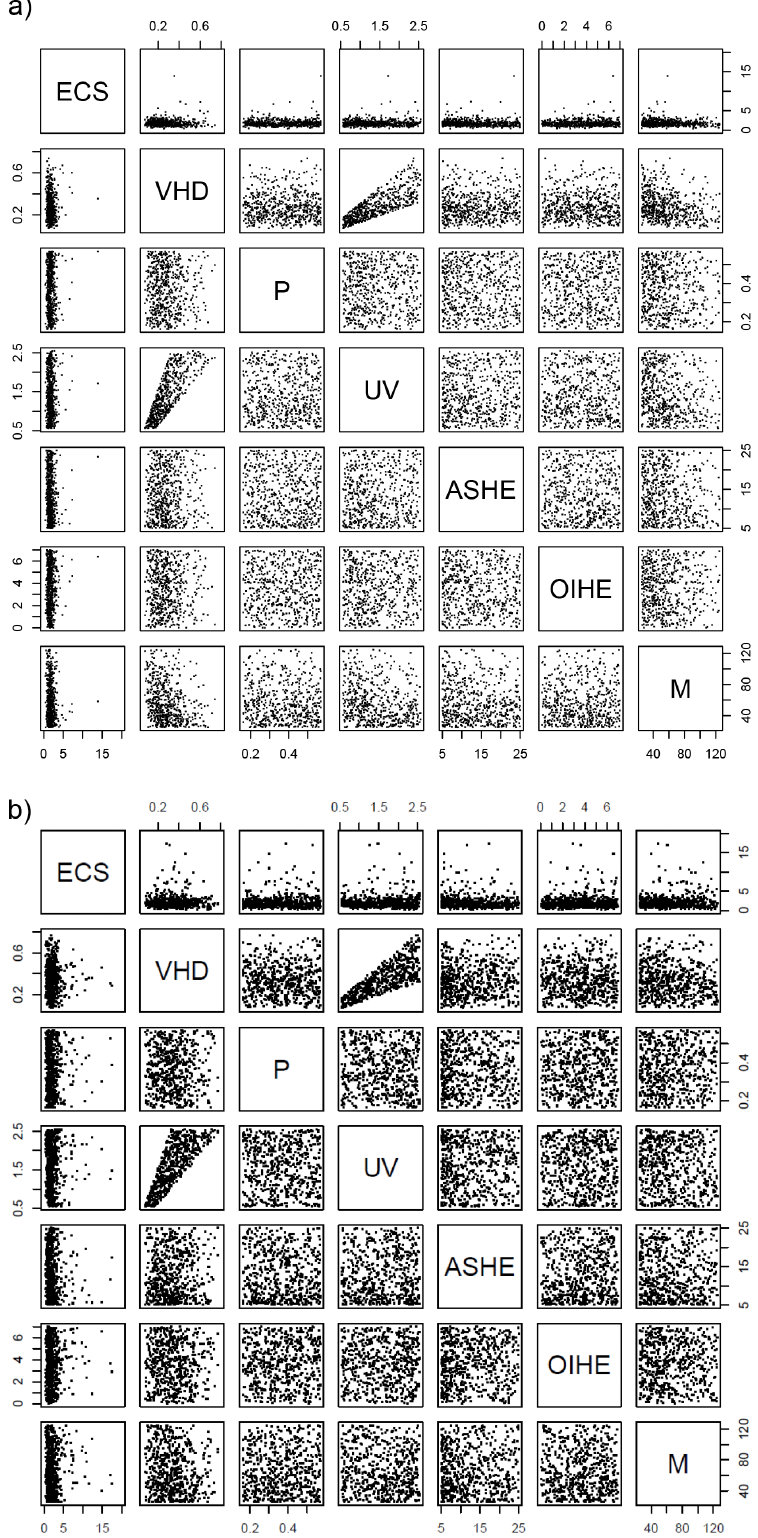
Fig. F2. Pair plots of samples from the posterior distribution for the model parameters ECS and θ = (θ VHD , θ P , θ UV , θ ASHE , θ OIHE , θ M ). In (a) the model is updated with data up to 2010, while in (b) the model is updated with data up to 2000.